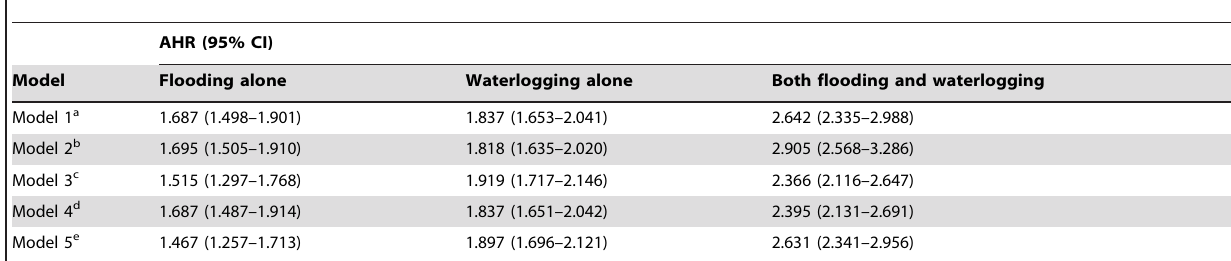
Table 1. AHRs of flooding and waterlogging on the risk of malaria in multivariate stratified Cox models.